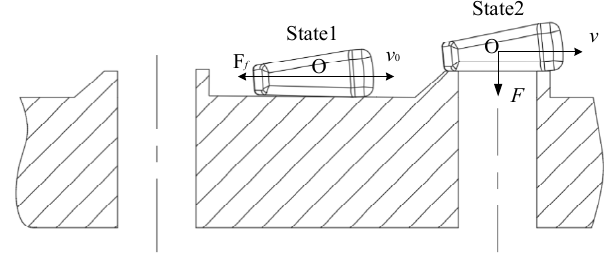
Figure 3. Schematic diagram of groove dragging seed.